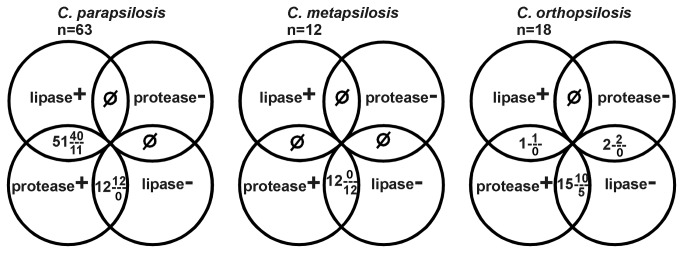
Diagrammatic presentation of the occurrence of lipase-, protease- and pseudohyphae-producer strains in the C. parapsilosis sensu lato complex.n: number of isolates, upper number in fraction: number of pseudohypha-producer strains, lower number in fraction: number of pseudohypha negative strains.